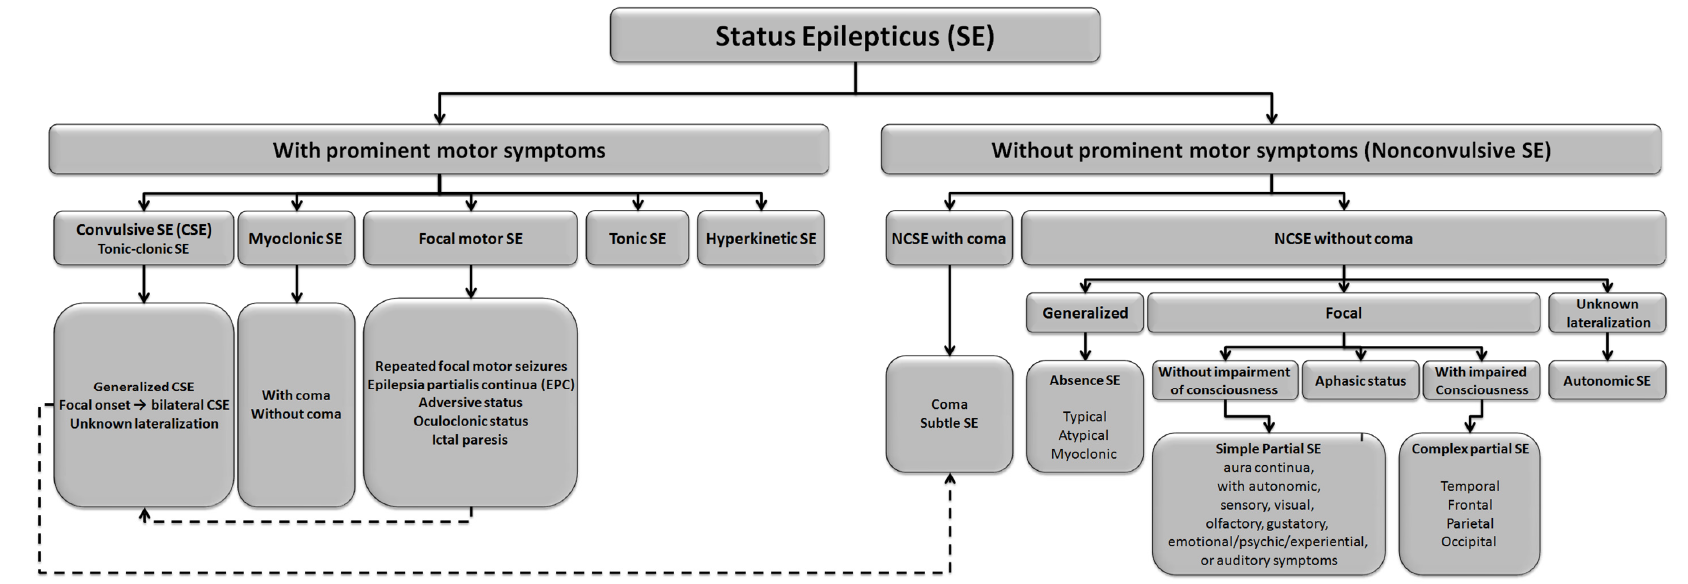
Figure 3. Classification of status epilepticus (adapted from the report of the ILAE Task Force on Classification of Status Epilepticus [12]).